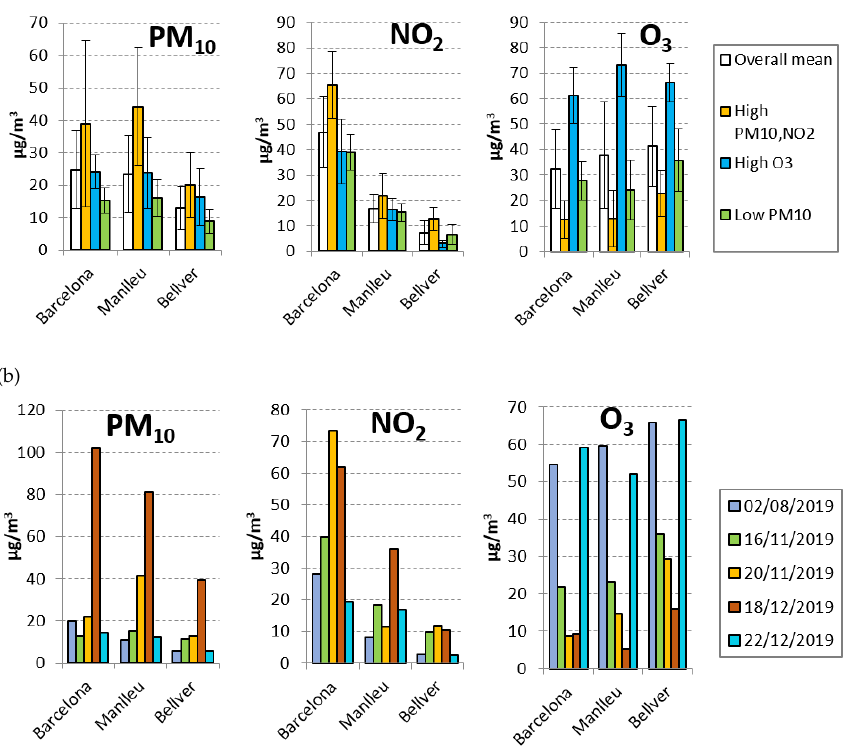
Figure 3. ( a ) Mean 24-h concentrations (and standard deviation) of PM 10 , NO 2 , and O 3 of the samples that were resolved in the MCR-ALS analysis into 3 groups of different criteria: (1) high PM 10 , NO 2 concentrations in the tree stations; (2) high O 3 concentrations in the three stations; (3) low PM 10 in the three stations. ( b ) Mean 24-h concentrations of PM 10 , NO 2 , and O 3 of the 5 days that were selected for organic tracer analysis and toxicity tests of the PM 10 filter